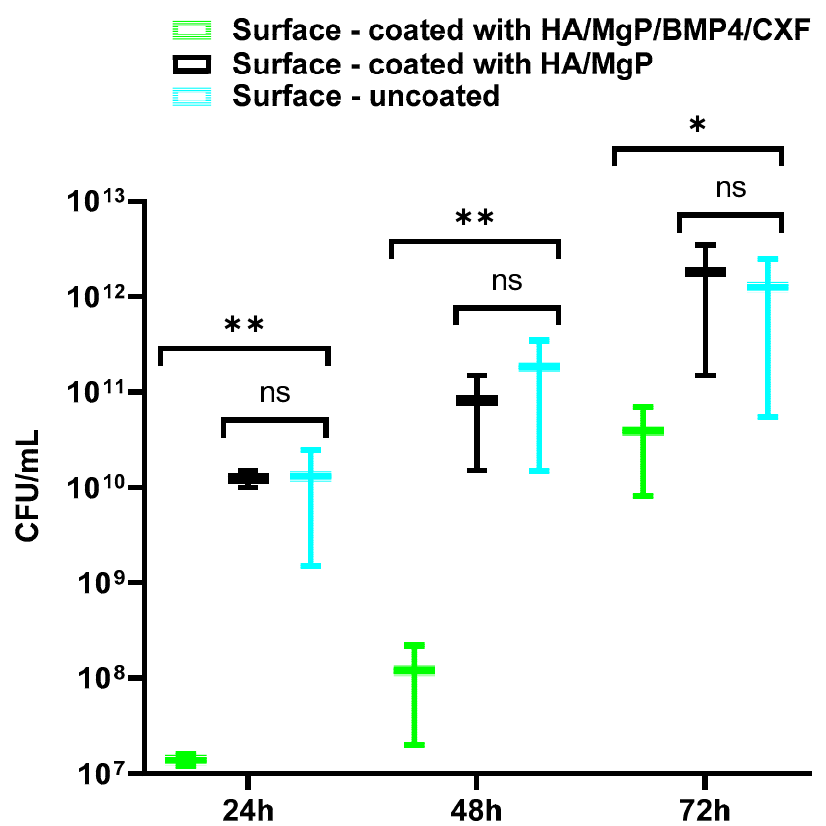
Figure 8. Antibiofilm efficiency assessment of the uncoated and coated surfaces against S. aureus at 24 h, 48 h, and 72 h; *— p ≤ 0.05; **— p ≤ 0.005; ns = not significant, p > 0.05.